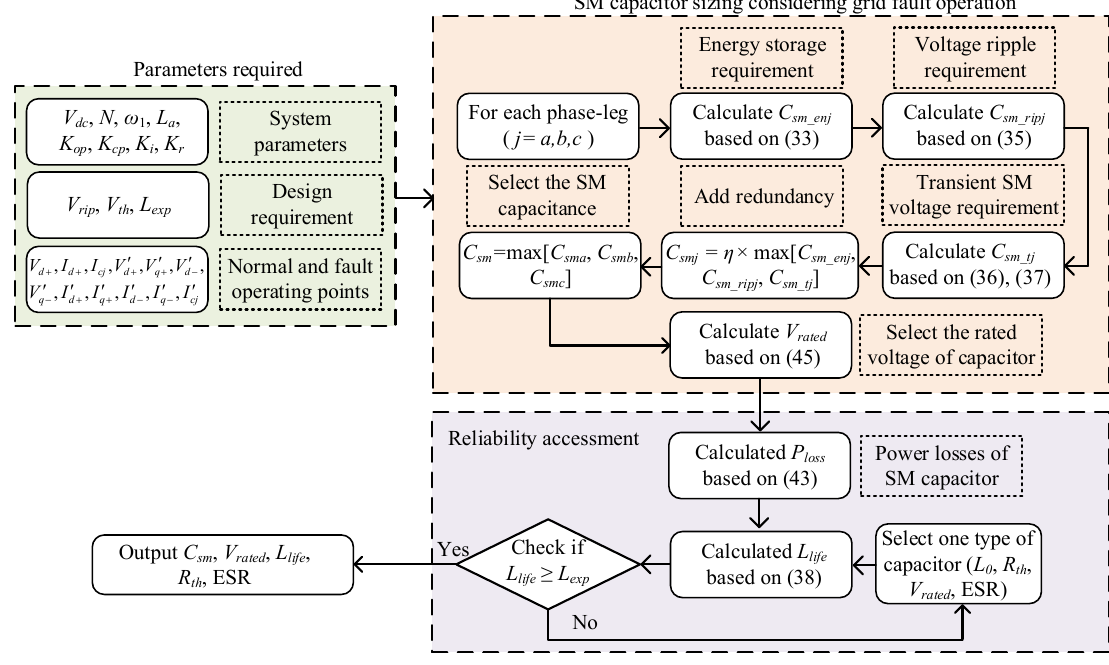
Figure 8. Design flowchart of SM